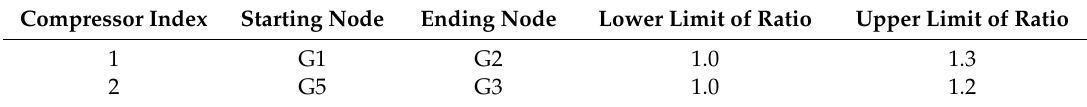
Table 5. Compressor parameters of natural gas network.